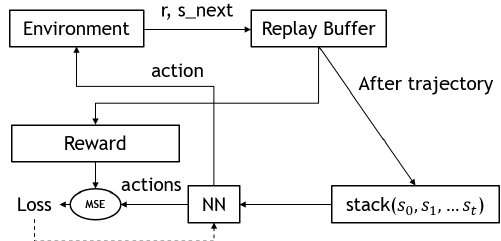
Figure 5. Flowchart of vanilla policy